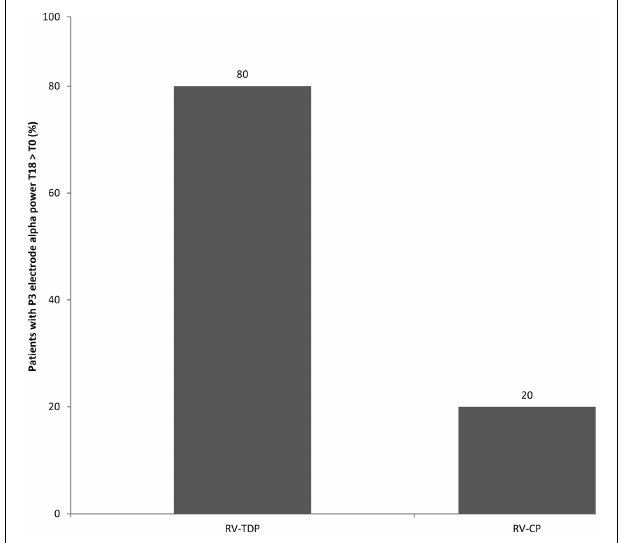
FIGURE 3 | Percentage of patients with increased alpha power atT18 follow-up as compared to the baseline measured at the P3 electrode (RV-TDP, rivastigmine transdermal patch; RV-CP, rivastgmine